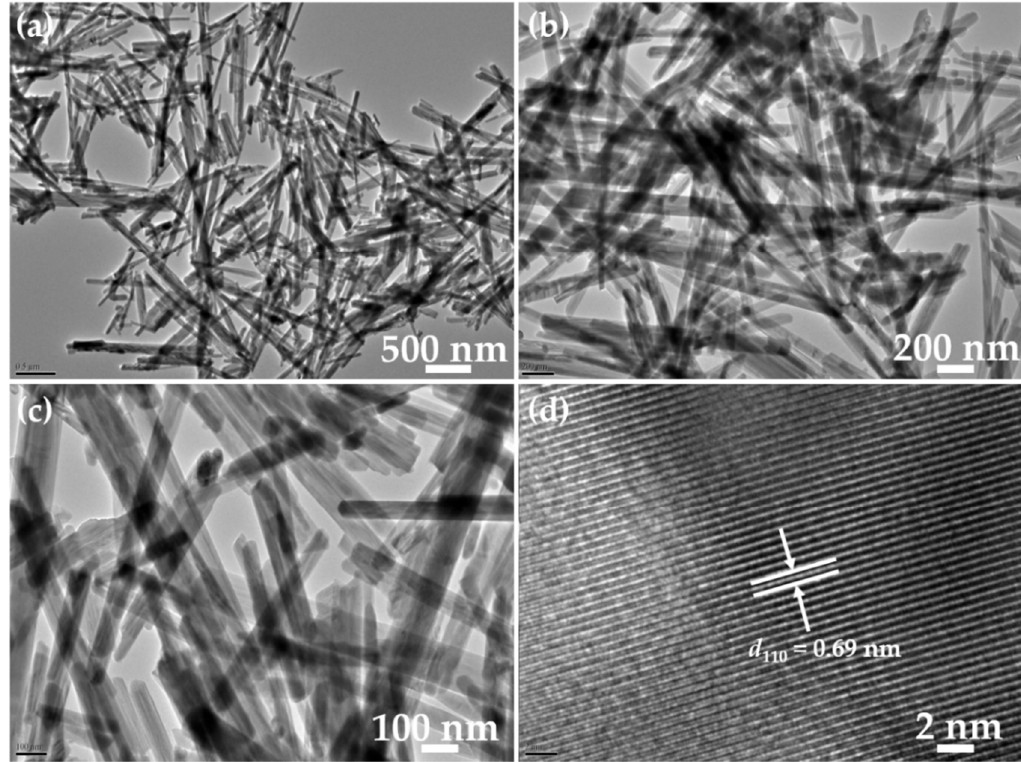
Figure 3. ( a , b ) Low resolution TEM images, ( c ) high resolution TEM image, and ( d ) HRTEM image for α -MnO 2 nanowires.